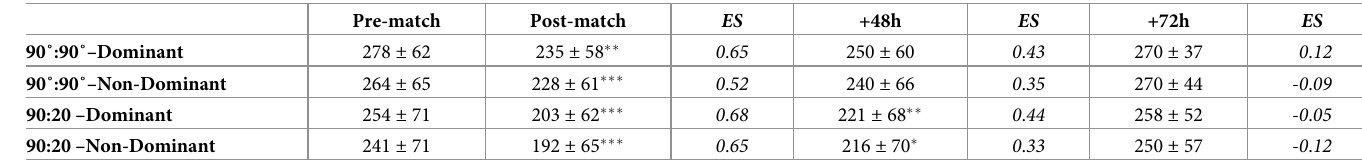
Table 2. Isometric peak force in 90:20 and 90˚:90˚ tests (mean ± standard deviation) immediately post, +48 and +72 post-match. Pre-match Post-match